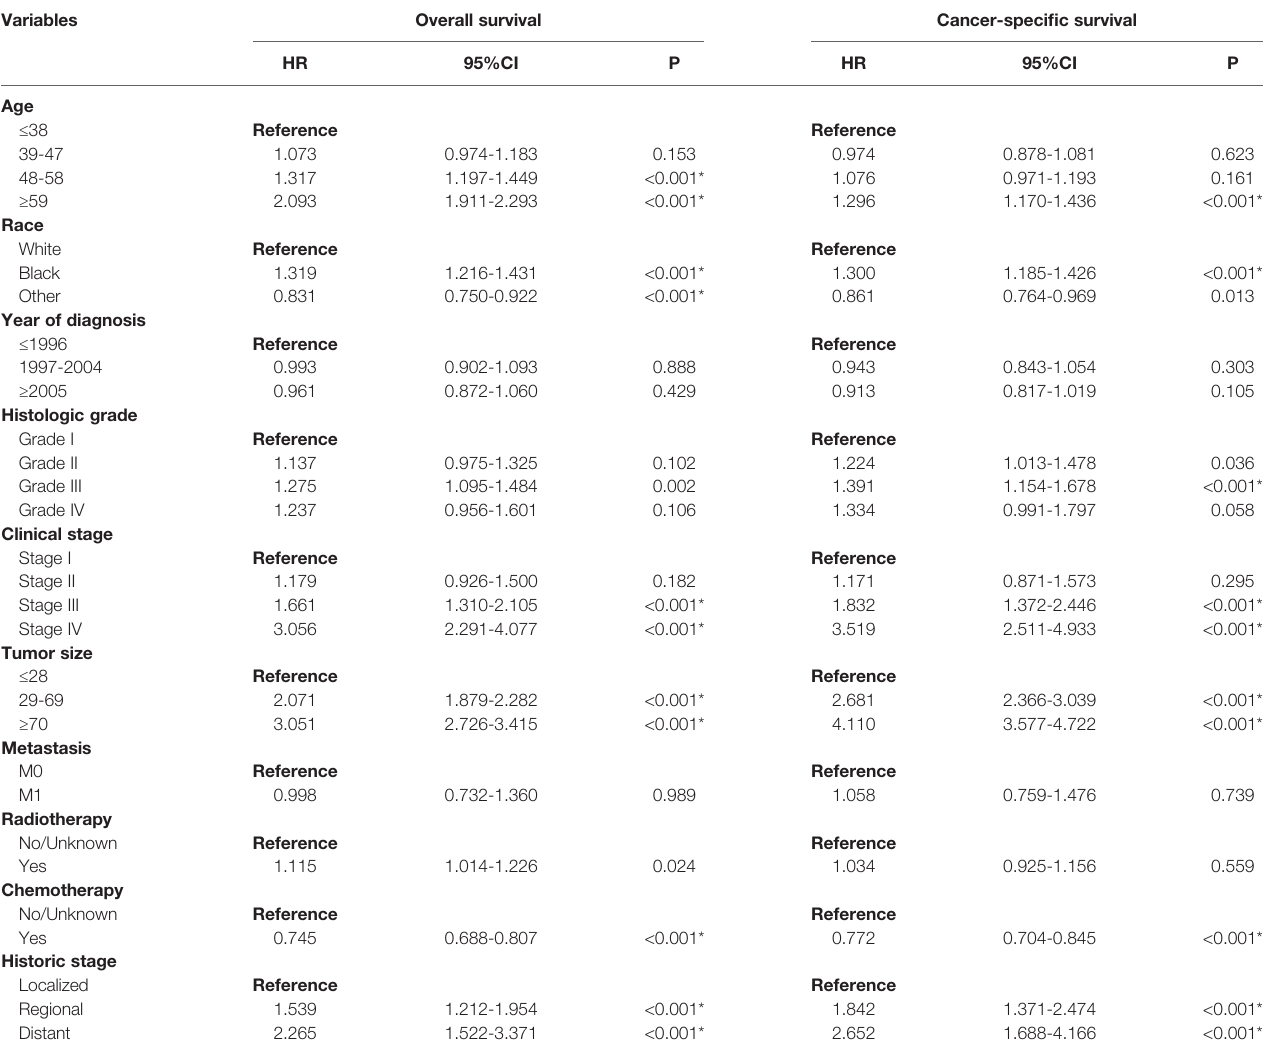
TABLE 3 | Multivariate Cox regression analysis of overall survival and cancer-speci fi c survival in cervical squamous cell carcinoma (training cohort). Variables Overall